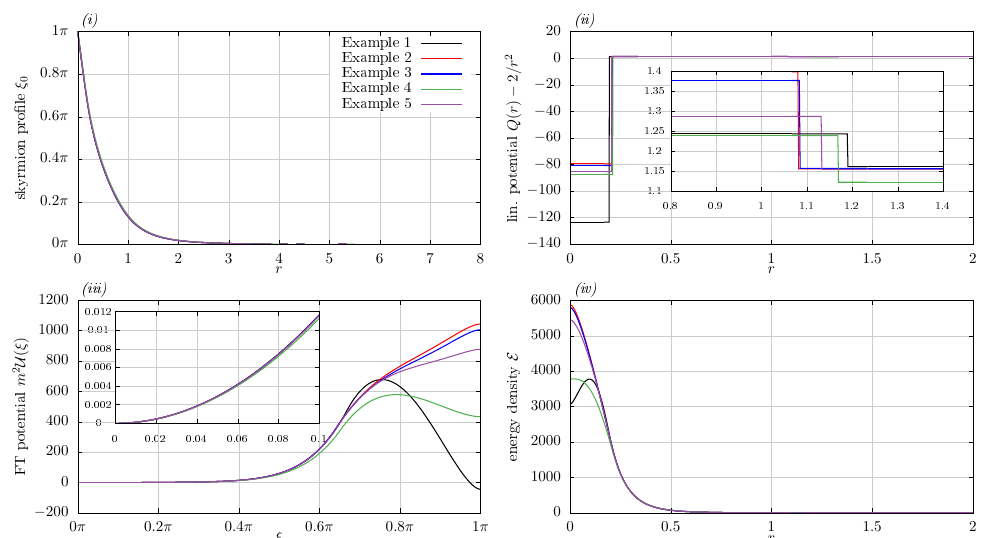
Figure 18 . Example solutions found from the reconstruction procedure (i) skyrmion pro(cid:12)les, (ii) the piecewise (cid:13)at linearized potentials Q ( r ) potentials, (iii) (cid:12)eld theoretic potential small values of (cid:24) , (iv) energy density. The plots are in Skyrme units.